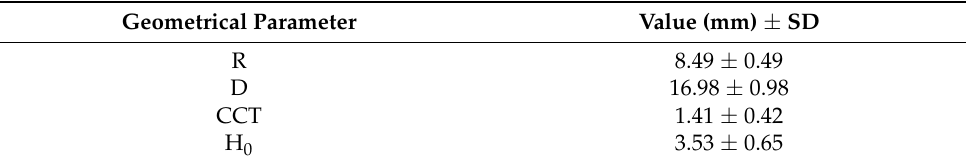
Table 3. Average values from image analysis of corneas during inflation tests. R, radius of curvature, D, in-plane diameter, CCT, thickness at the apex, and H 0 , the elevation of the apex in the unstressed condition.